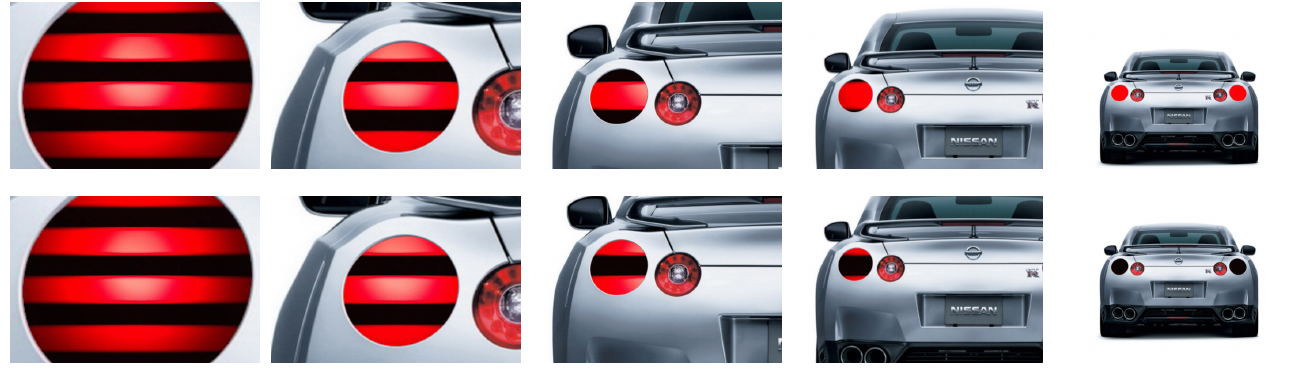
Figure 5. Car with modulated taillights at various distances from close-up to farther away